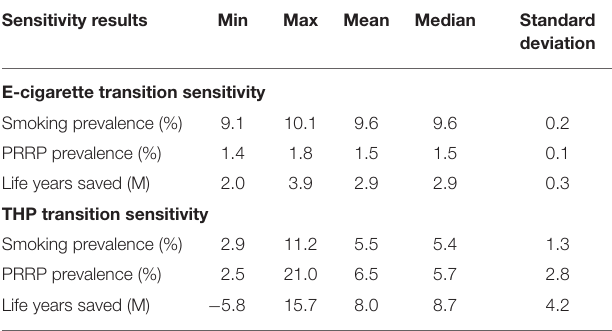
TABLE 6 | Summary sensitivity results across all 1,000 projections for the E-cigarette and THP scenarios.